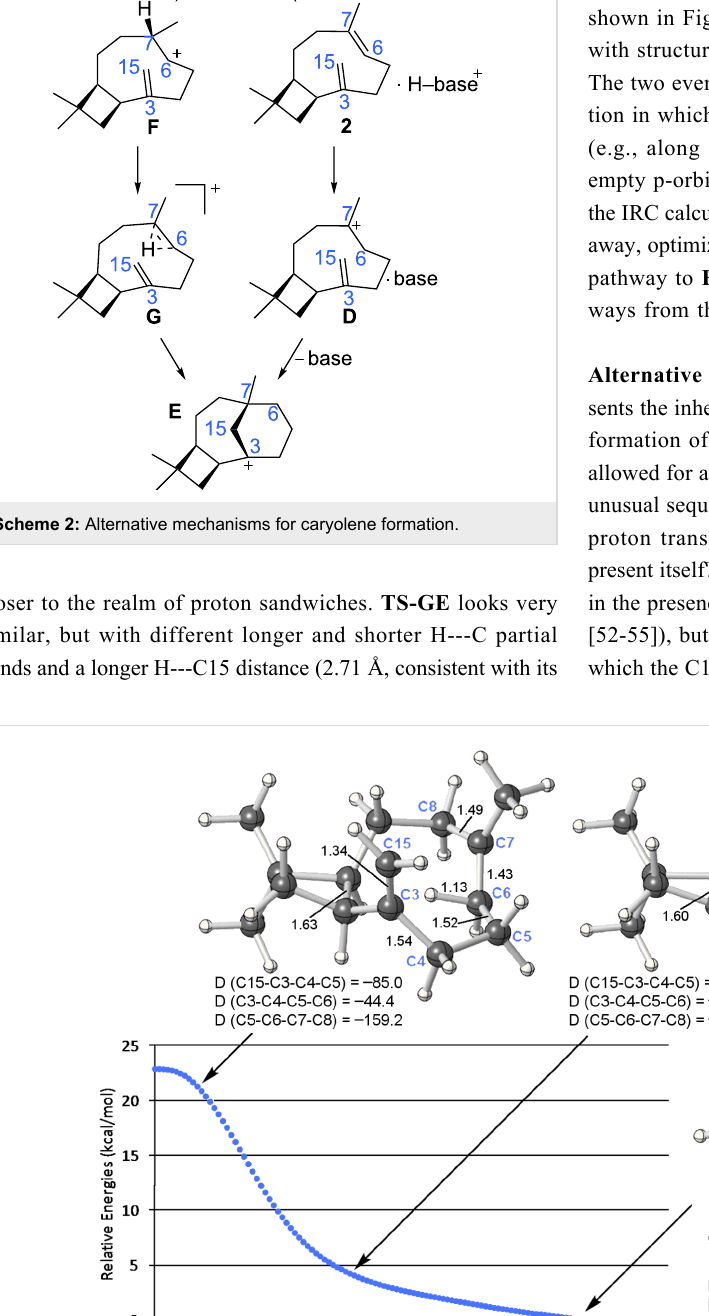
Figure 6: IRC from TS-GE toward E . Relative energies were calculated at the B3LYP/6-31+G(d,p) level. Selected dihedral angles are shown in degrees.